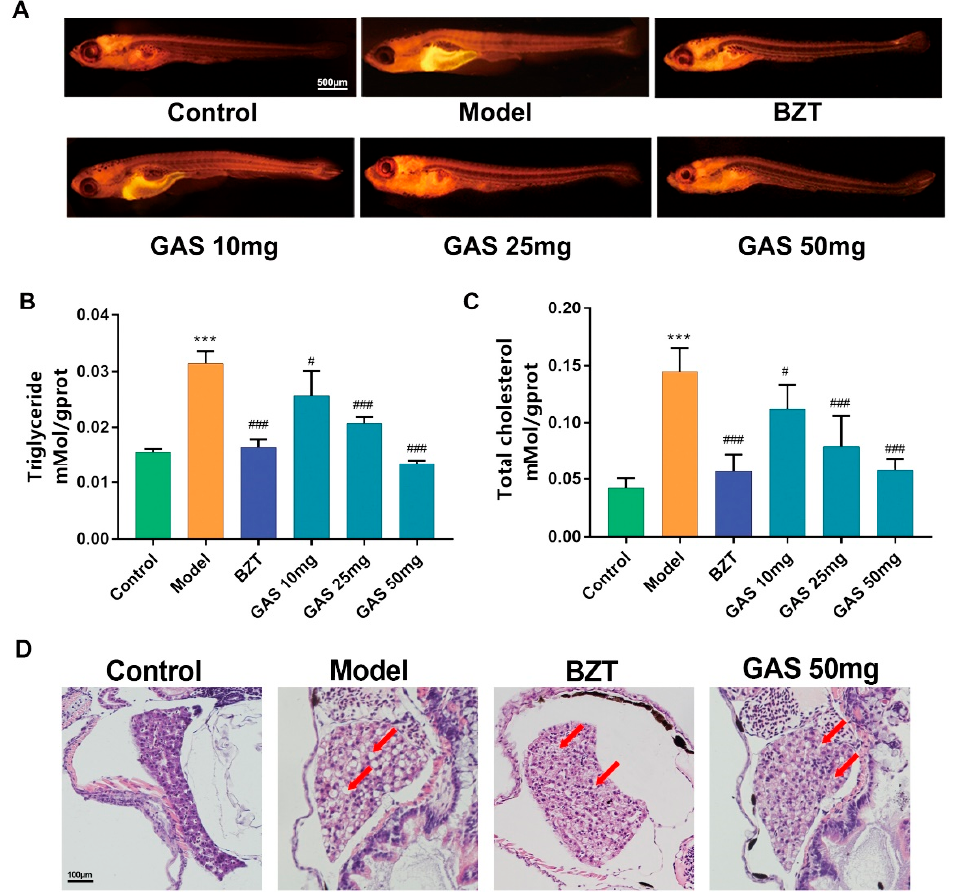
Figure 3. Lipid is regulating the e ff ect of GAS on HCD induced larval zebrafish. ( A ) Nile red stain of larval zebrafish; ( B ) Triglyceride (TG) levels; and ( C ) total cholesterol (TC) levels of larval zebrafish in each group. ( D ) hematoxylin and eosin (HE) staining of larval zebrafish liver, macrovesicular steatosis and the differences mentioned with red arrows. Bar indicate means ± SD. *** p < 0.001 represent compared with the control. # p < 0.05, ### p < 0.001 represent compared with Model. p < 0.05 was considered as statistically significant, calculated by One-way ANOVA, followed by Tukey’s test. (n = 30).